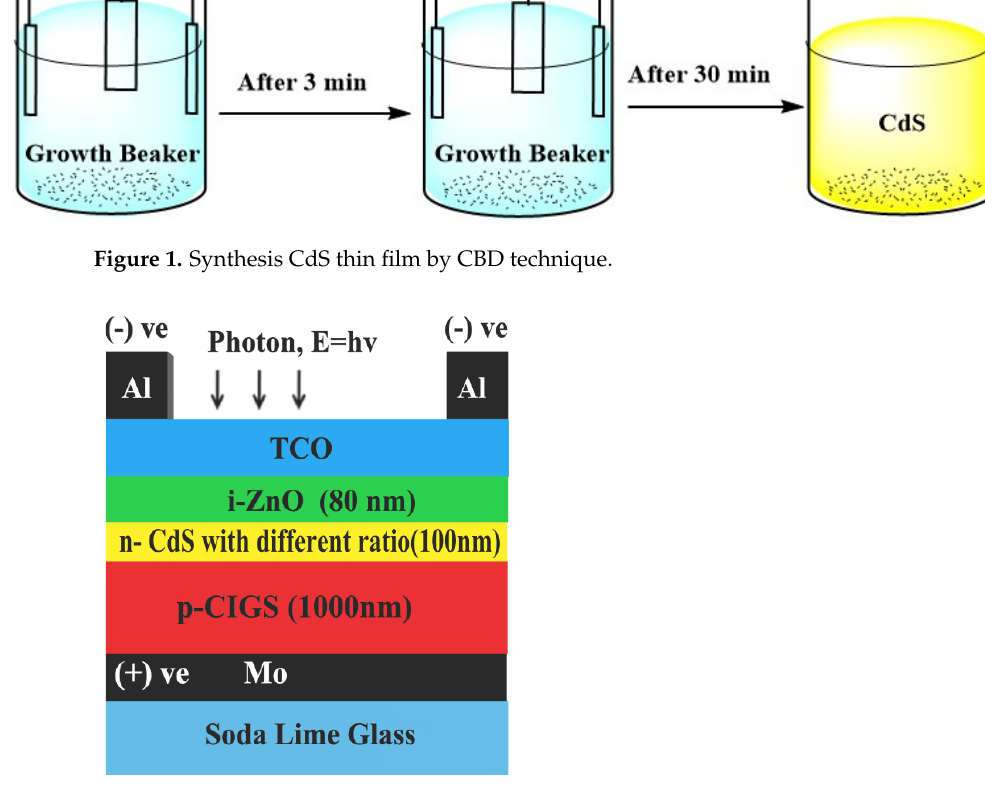
Figure 1. Synthesis CdS thin film by CBD technique.